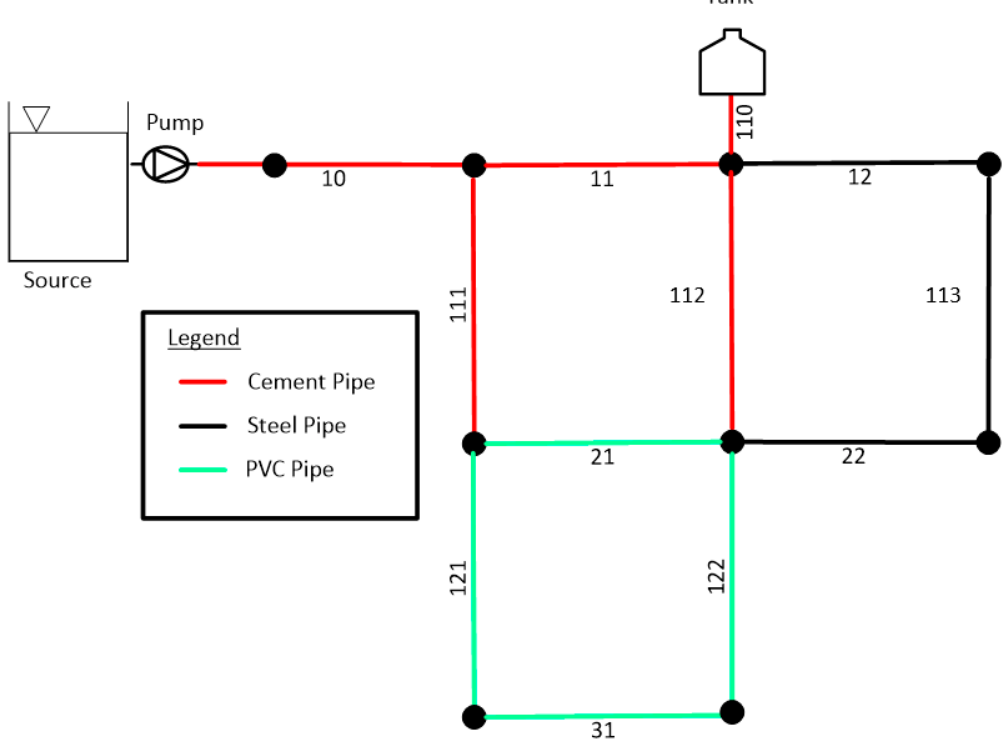
Figure 3. EPANET example 1 with classification.